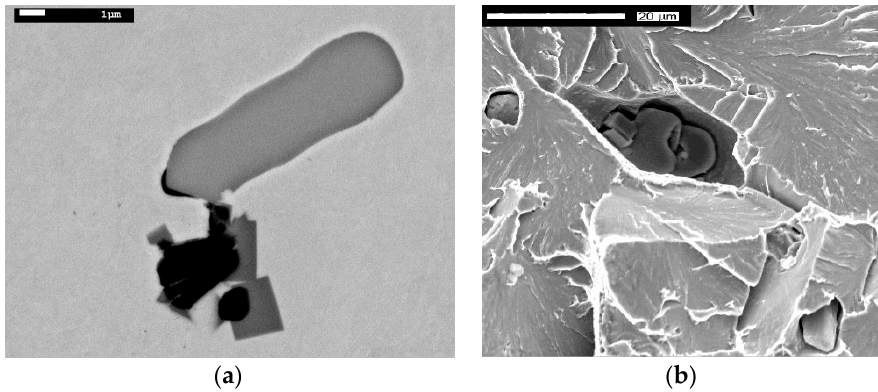
Figure 15. Nonmetallic inclusions in non-modified cast steels: ( a ) metallographic sample; ( b ) on the fracture surface of the Charpy-V impact test.